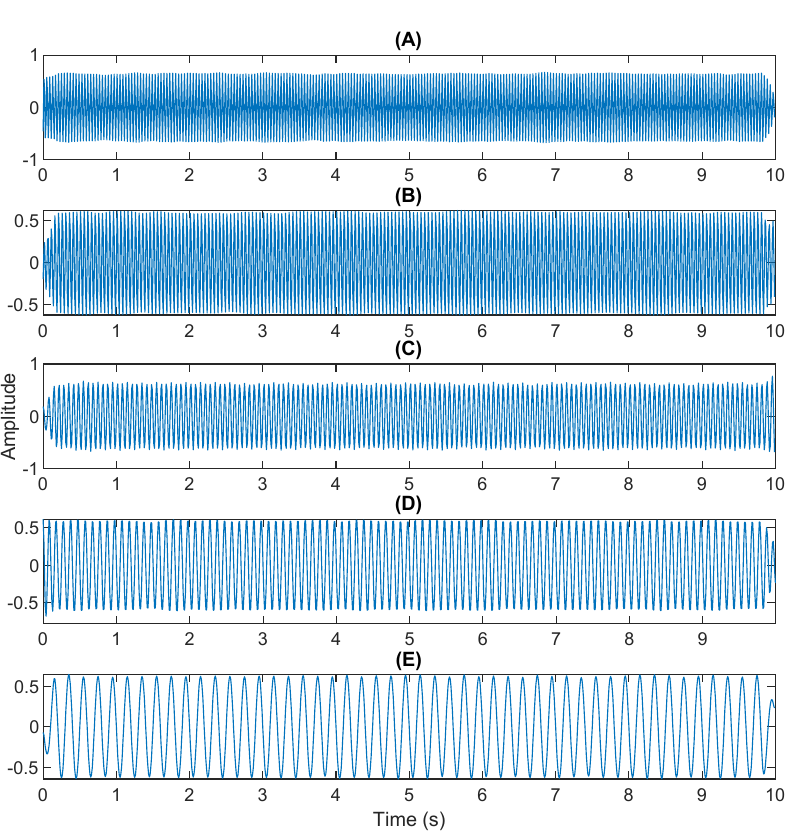
Figure 6. Analysis of data separated by ICA-VMD: ( A ) 25 Hz sin waveform; ( B ) 20 Hz sin waveform; ( C ) 15 Hz sin wave- form; ( D ) 10 Hz sin waveform; ( E ) 5 Hz sin waveform.